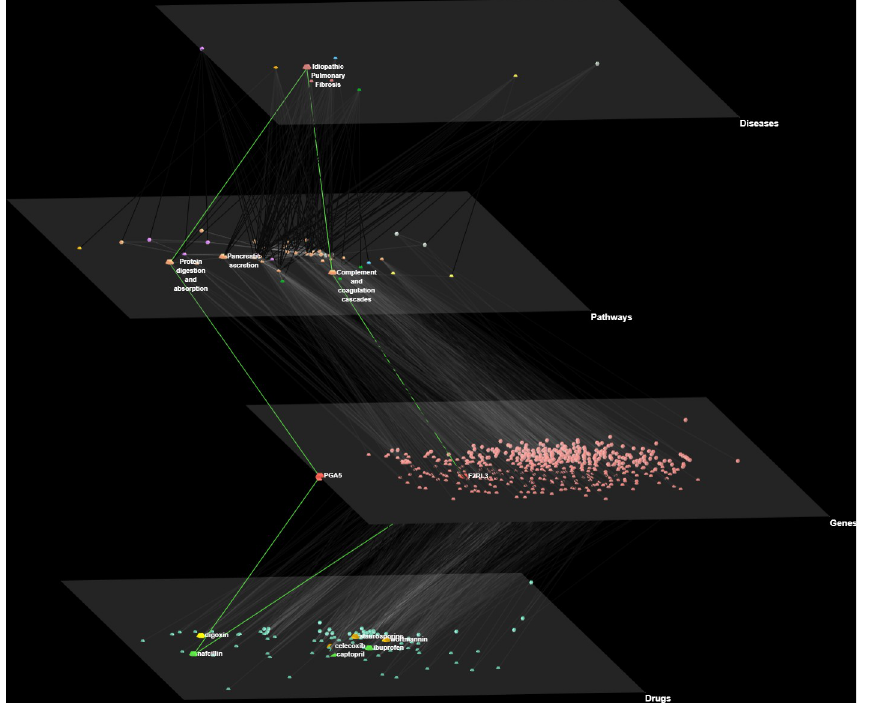
Fig 9. Multi-layer visualization of fibrotic diseases, pathways, genes and candidate repurposed drugs. In this network, we have scaled-up and labeled IPF in the disease layer, its respective 3 discussed pathways in the pathway layer and the 7 discussed repurposed drug candidates in the drug layer. Furthermore, we scale up and annotate 2 gene targets of nafcillin in the gene layer, PGA5 and F2RL3, which participate in “Protein digestion and absorption” and “Complement and coagulation cascades” pathways respectively. The respective edge paths are highlighted in green